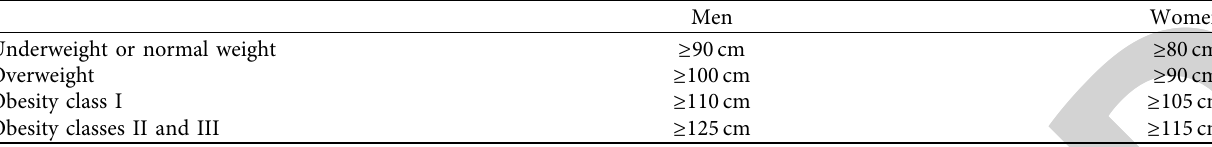
Table 1: Sex- and BMI-specific thresholds for